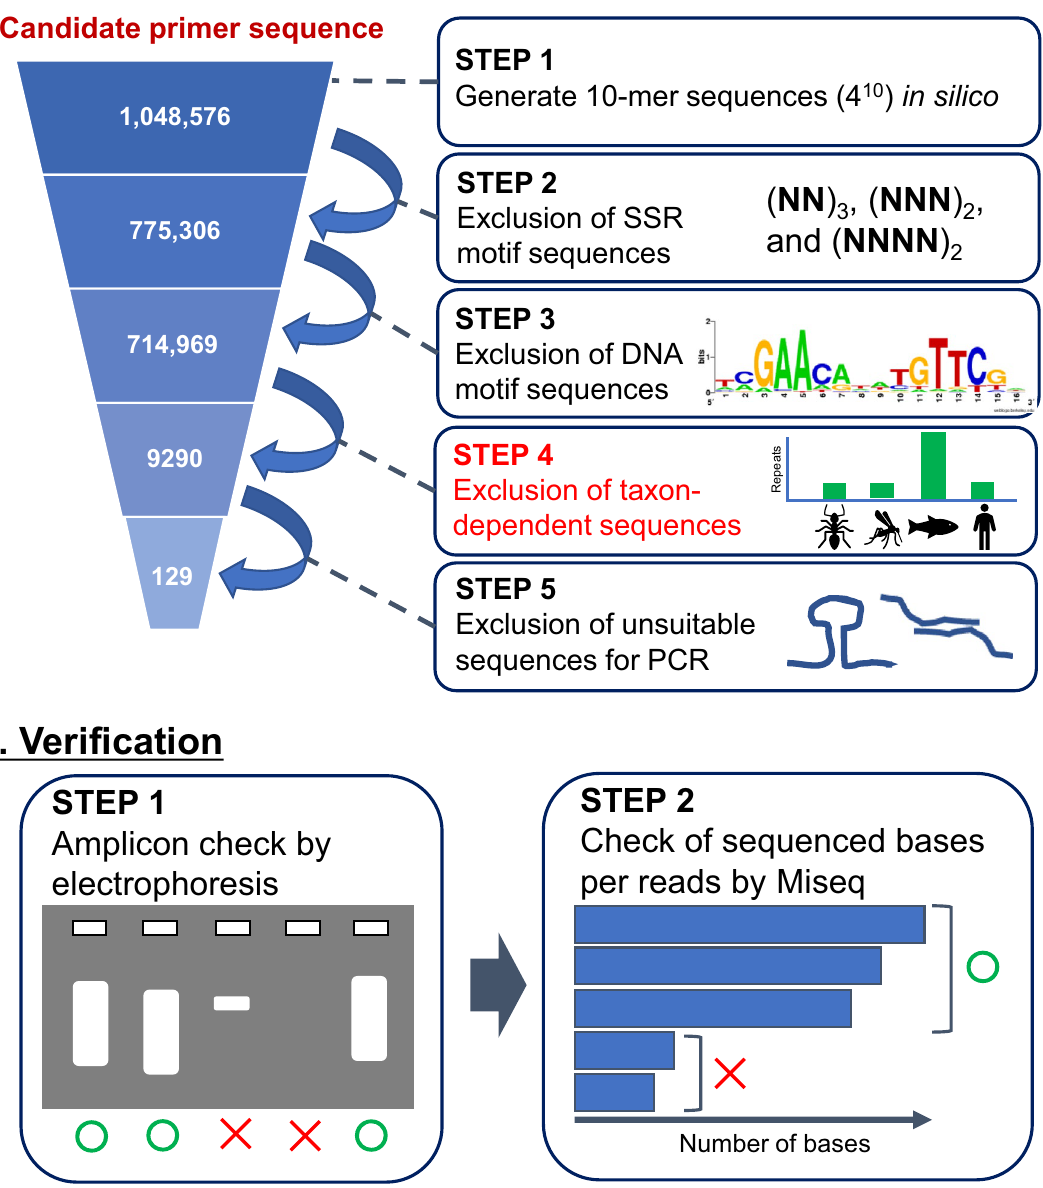
Figure 1. Workflow showing primer design and verification by multiple arbitrarily amplicon